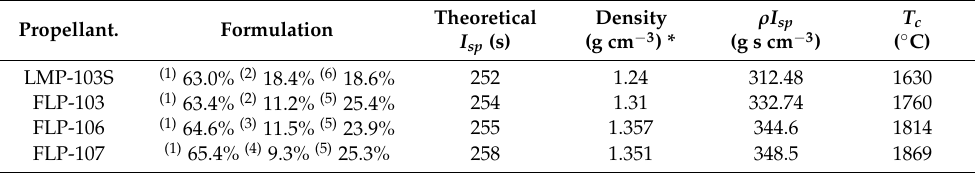
Table 5. ADN-based monopropellants properties [22,57,58] (ideal vacuum I sp by [57] using